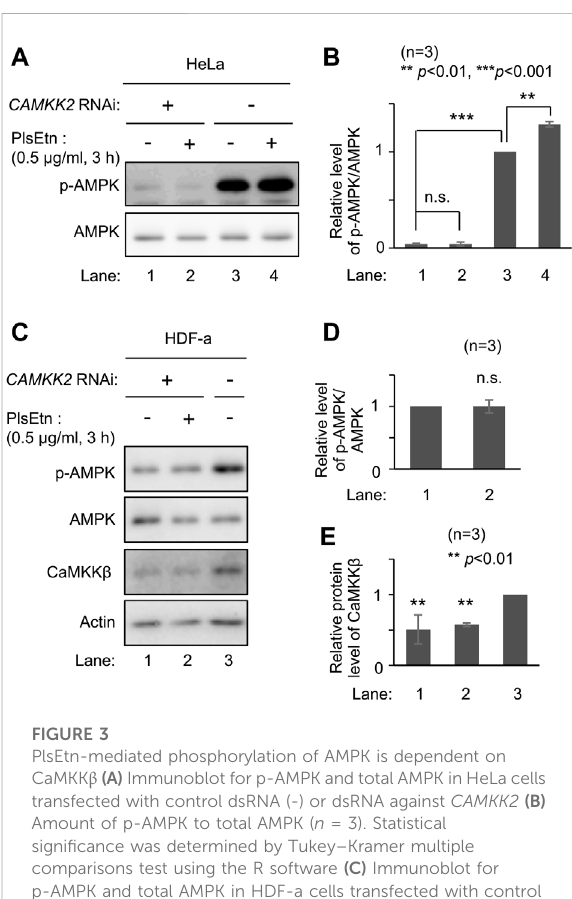
FIGURE 3 PlsEtn-mediated phosphorylation of AMPK is dependent on CaMKK β (A) Immunoblot for p-AMPK and total AMPK in HeLa cells transfected with control dsRNA (-) or dsRNA against CAMKK2 (B) Amount of p-AMPK to total AMPK ( n = 3). Statistical signi fi cance was determined by Tukey – Kramer multiple comparisons test using the R software (C) Immunoblot for p-AMPK and total AMPK in HDF-a cells transfected with control dsRNA (-) or dsRNA against CAMKK2 (D) Amount of p-AMPK to total AMPK in (C) ( n = 3) (E) Protein level of CaMKK β normalized to that of actin ( n = 3).